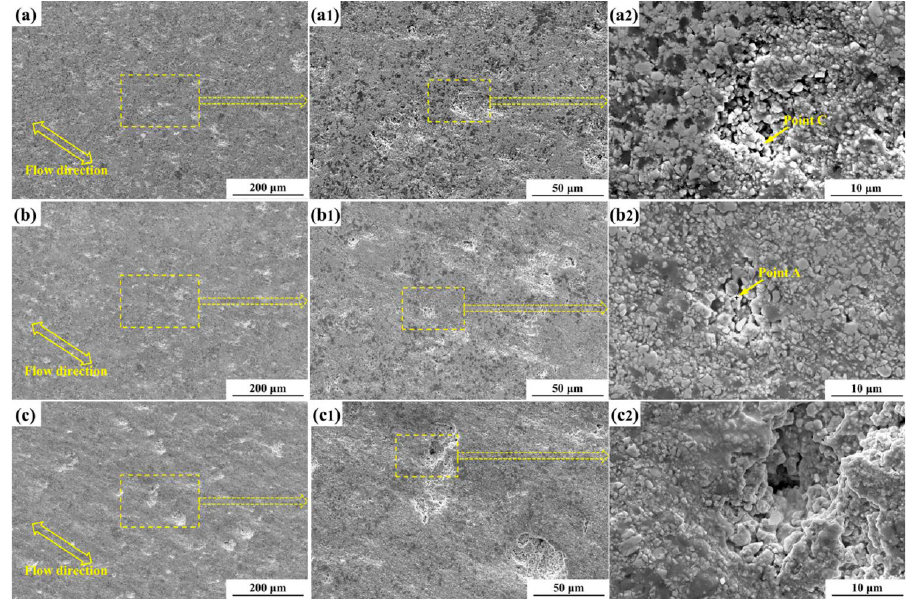
Figure 10. FE-SEM images of the WC-Cr 3 C 2 -Ni coatings after CSE for 6 h in 3.5 wt.% SCM at 33.5 m·s − 1 and different SCs: ( a ) 10 kg·m − 3 , ( b ) 20 kg·m − 3 , ( c ) 35 kg·m − 3 .